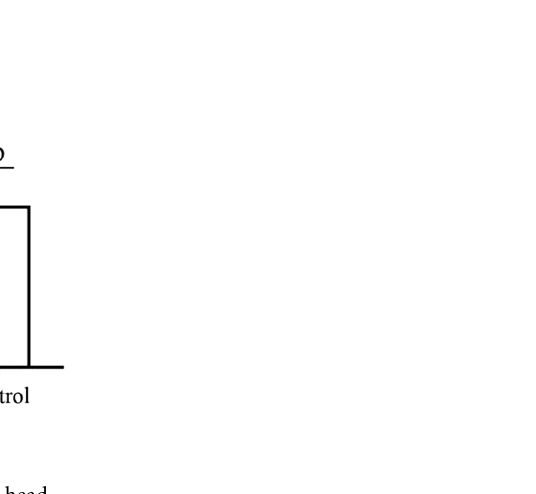
Figure 2. Occurrence time of raising or turning